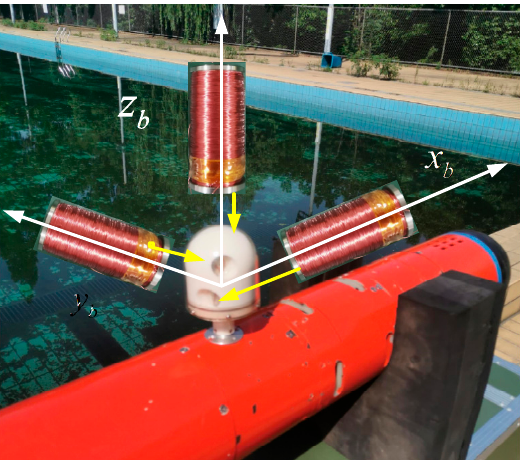
Figure 4. The composition and installation of the triaxial-coil magnetometer in AUV body coordinates. The length and diameter of each coil in the magnetometer are 47 mm and 25 mm, respectively. Each coil is wound with 0.2 mm copper wire, with a total of 12,000 turns. The parameters of the three coils are designed to be consistent, so one of them is analyzed here. According to Faraday’s law, if the magnetic field component in the axial direction of the . H axis , the permeability of the material around the coil is µ , the turn of the coils is n , coil is and the average area of the coil is S , then the complex vector of the induced voltage is: